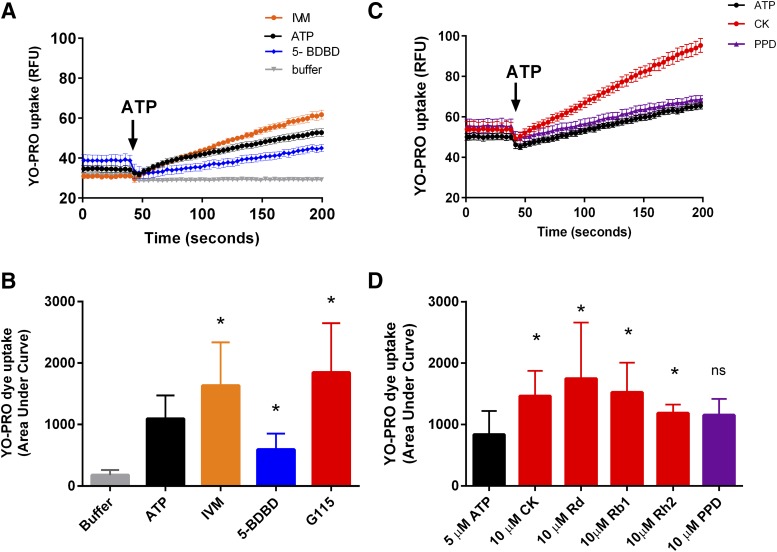
Protopanaxadiol ginsenosides and G115 increase hP2X4-mediated YOPRO-1 uptake responses. (A) Representative data showing YOPRO-1 uptake in response to ATP (5 µM) in the presence of ivermectin (IVM, 3 µM) or 5-BDBD (20 µM). (B) Summary area under curve data from normalized YOPRO-1 uptake in HEK-hP2X4 cells (n = 3 independent experiments). Error bars represent S.D.; *represents P < 0.05 by one-way ANOVA with Dunnett’s multiple comparison post hoc test. (C) YOPRO-1 uptake responses in HEK-hP2X4 cells to ATP (5 µM) in low divalent buffer solution (black) or ATP plus PPD (purple; 10 µM) and ATP plus CK (red; 10 µM). Ginsenosides were coinjected with the agonist ATP. (D) Data have been quantified as area under dye uptake curve (50–180 seconds). Bar graphs show data from three to five independent experiments. Error bars represent S.D.; *represents P < 0.05 by one-way ANOVA with Dunnett’s multiple comparison post hoc test, ns represents not significant.